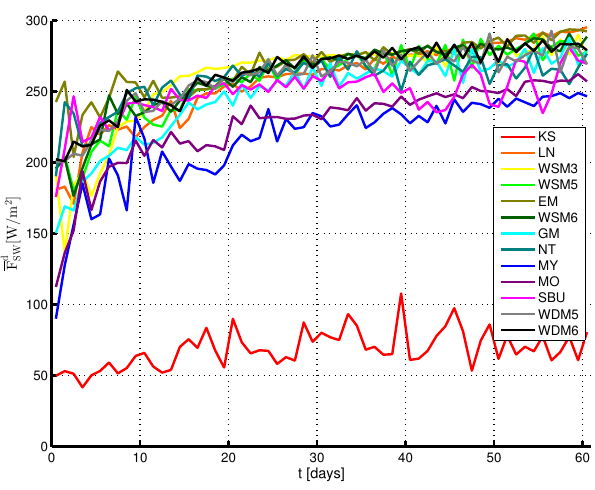
Fig. 10. Comparison of the daily averaged values of the mean DSR flux at the surface for the 13 microphysical